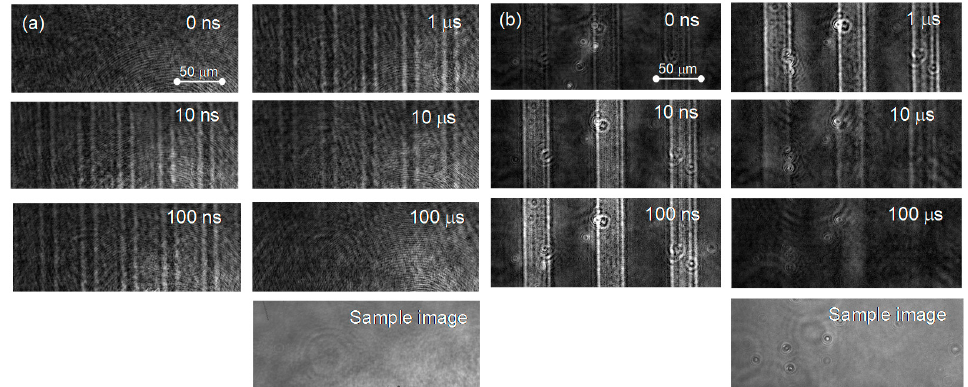
Figure 1. The PI-PM image sequences for ( a ) a single crystal and ( b ) a particulate TiO 2 film are shown. The optical images of the samples obtained under the same optical setup are also shown at the bottom of the sequences.